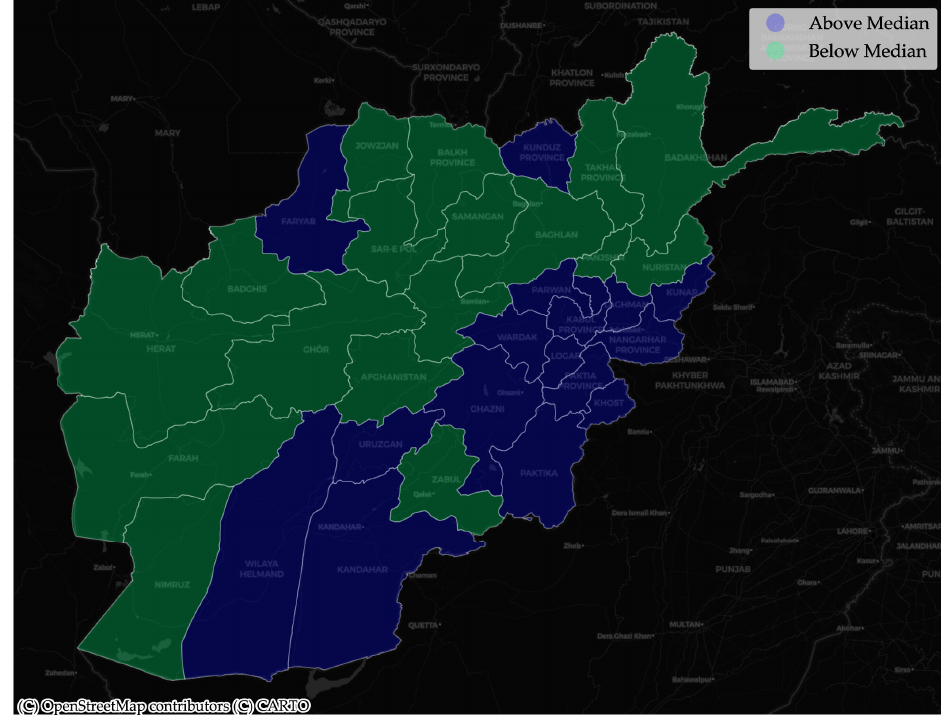
Figure 6. Segregation of Afghanistan provinces using the GTI-IS density statistic. Table 6. Joint count statistics for spatial autocorrelation in Afghanistan.